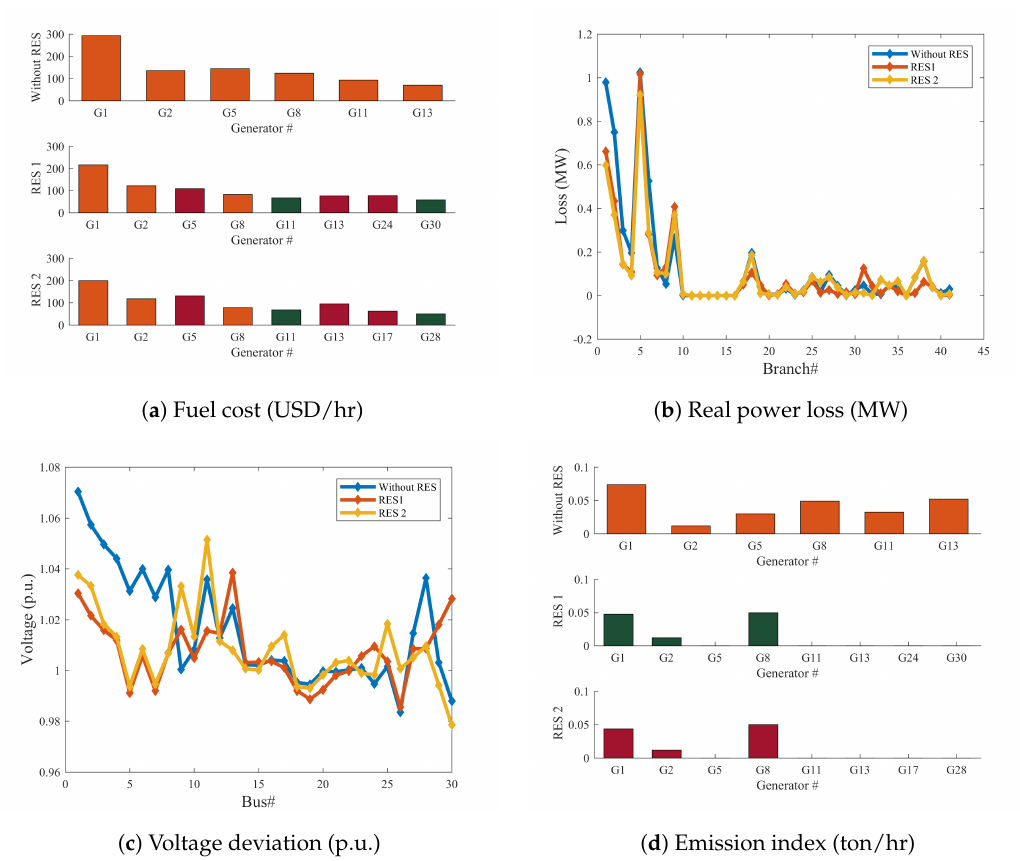
Figure 15. The total power generation cost, real power loss, voltage deviation, and Emission index IEEE 30-bus system, IEEE 30-bus Modified (1) and IEEE 30-bus Modified